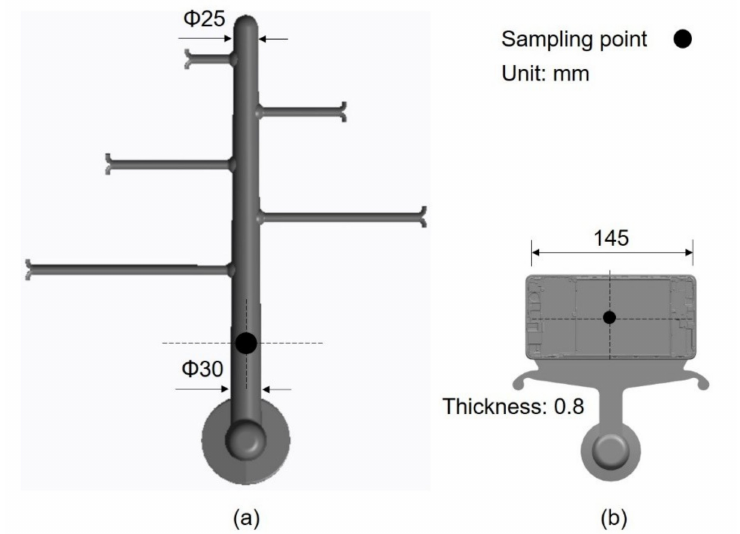
Figure 2. Schematic diagram of castings with ( a ) thick-wall for 30 mm thickness and ( b ) thin-wall for 0.8 mm thickness in semi-solid die